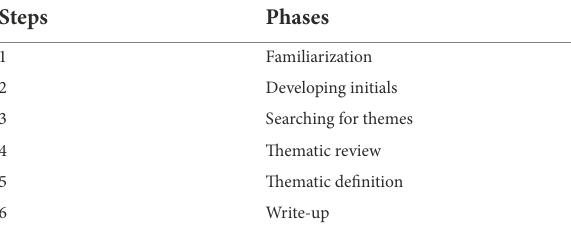
TABLE 3 Six phases of thematic analysis (TA) of Braun and Clarke